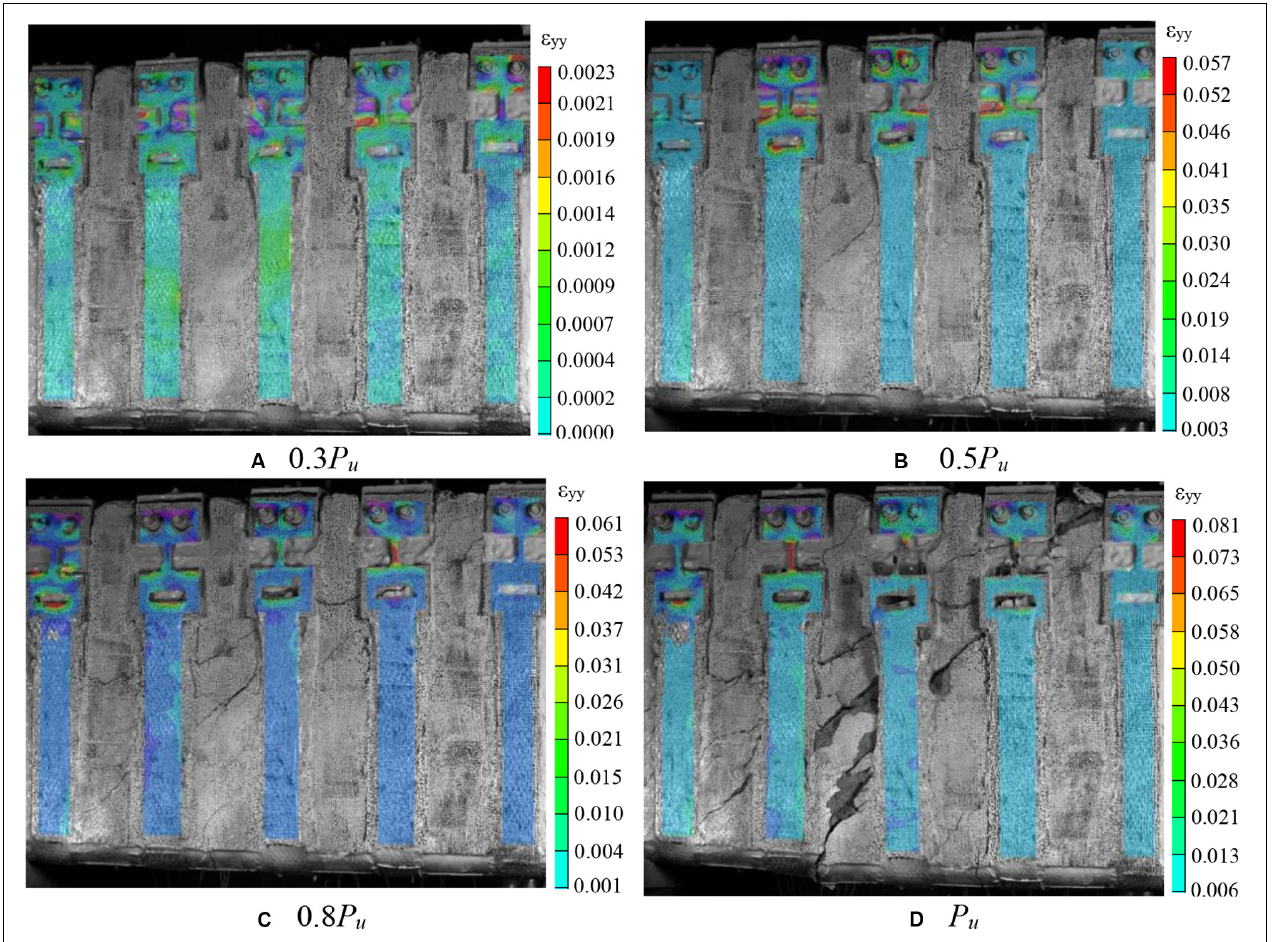
FIGURE 16 | Strain distribution of H-type anchor for EA-4-5 measured by DIC. (A) 0.3 P u , (B) 0.5 P u , (C) 0.8 P u , and (D) P u